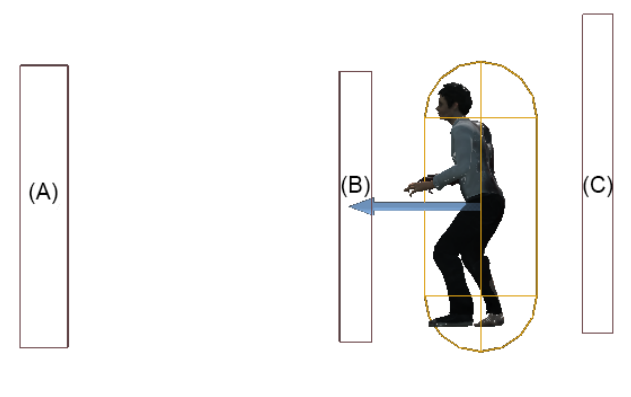
Figure 8. A lateral view of the mesh composing the enemy and its associated three intersection bounding boxes, assuming that the avatar approaches the enemy from the left. Box labelled as ( A ) is used to detect the moment the avatar is close enough to the enemy to trigger an enemy attack. Box labelled as ( B ) is used for detecting ray–enemy intersections (to determine which object is being attended by the player) as well as bullet-enemy intersections. Box labelled as ( C ) allow the system to detect the moment the avatar passes beyond the